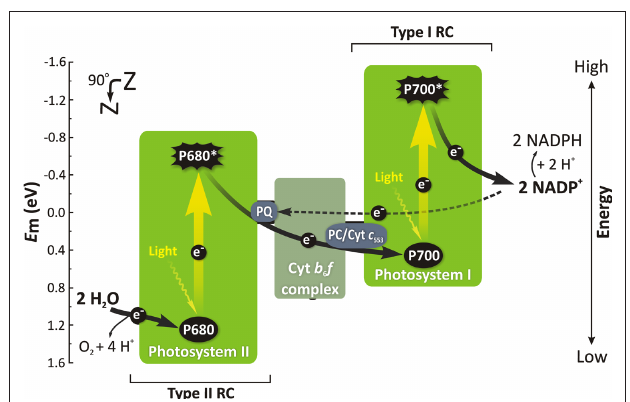
FIgurE 4 | A simplified Z-scheme representing the linear (black solid arrows) and a cyclic (black dashed arrow) electron transport in cyanobacteria. Straight yellow arrows are for excitation of RC Chl a molecules that leads to electrons in the ground state to be raised into higher (singlet) excited state (P680 in PSII and P700 in PSI) in response to the absorption of light quanta (wavy arrows) via the antenna system (see Figure 2 ). Other abbreviations: E (eV), redox potential at pH 7 (in electron volts); e − , electron; m PQ, plastoquinone; Cyt